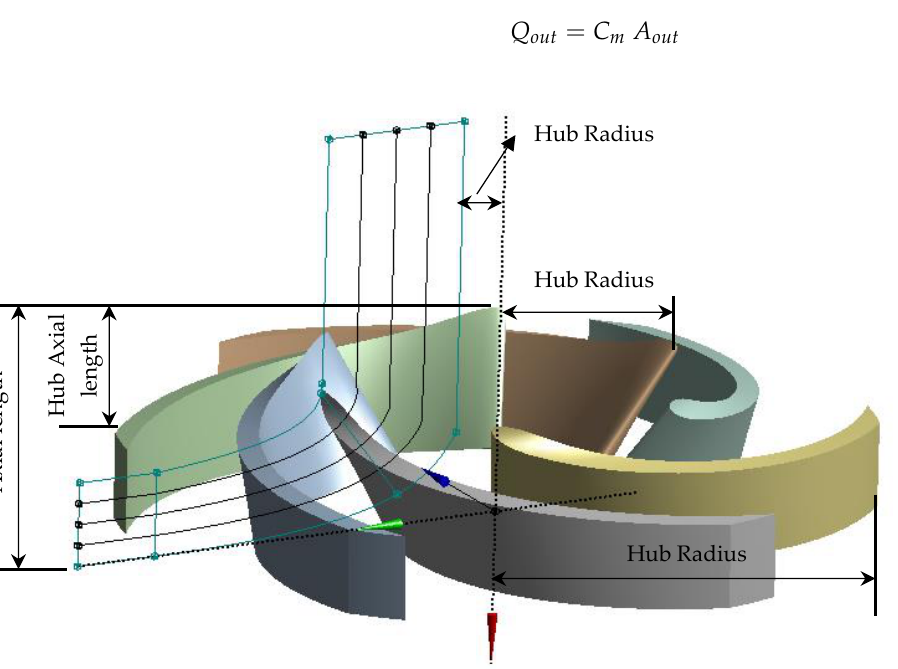
Figure 1. Initial impeller geometry generated using ANSYS Vista CPD.